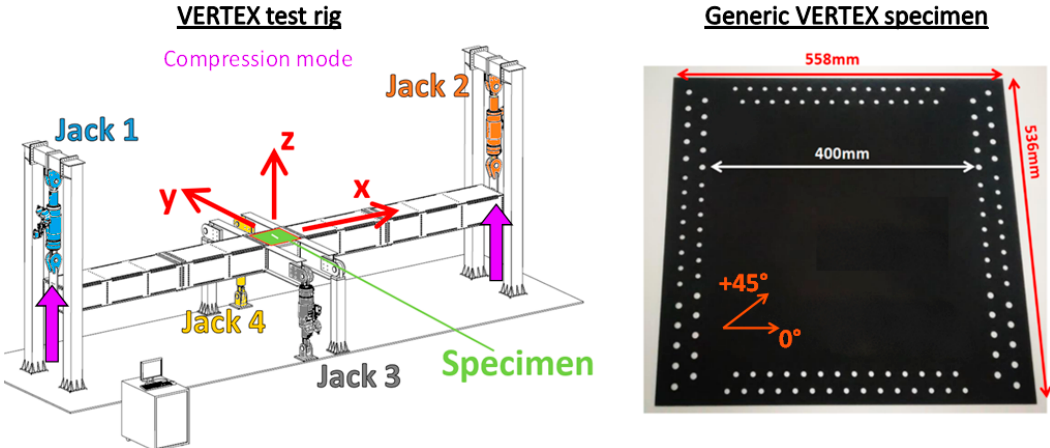
Figure 3. ( left ) VERTEX test rig illustration; ( right ) Generic shape of a flat VERTEX specimen.